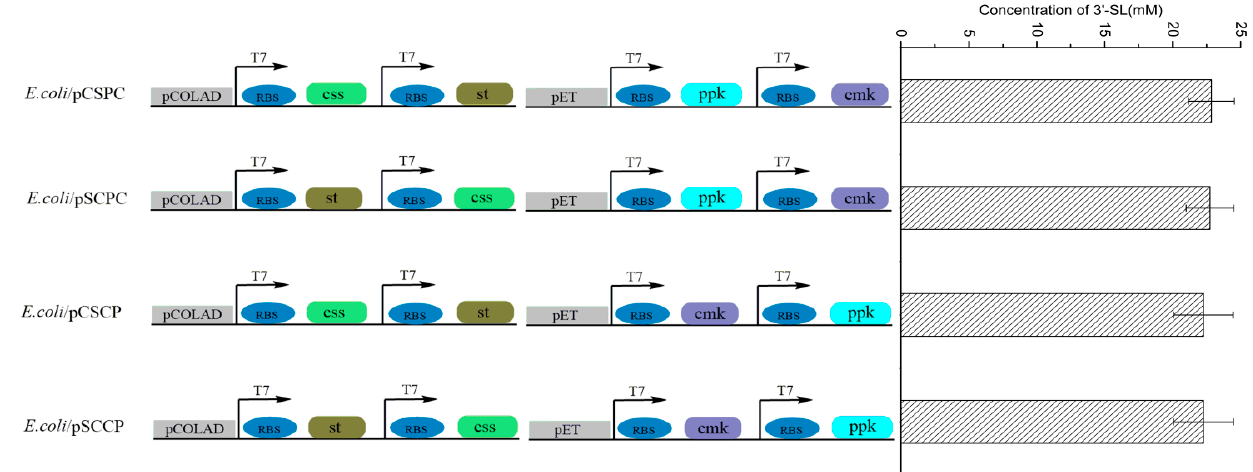
Figure 2. Optimization of 3 ′ -SL production by different combinations of plasmids.